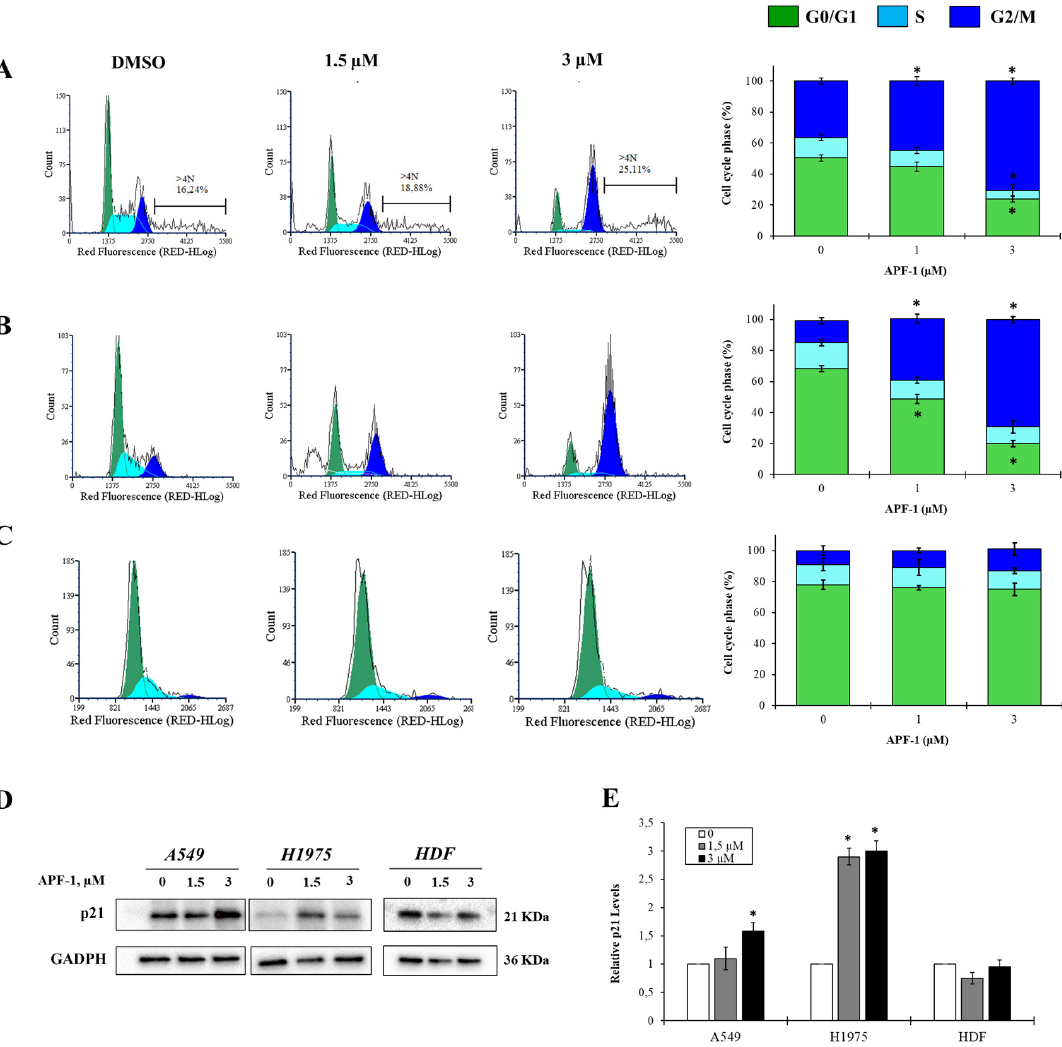
Figure 4. Effects of APF-1 on cell cycle distribution and p21 waf1/cip1 expression. Cells were treated for 24 h with 1.5 and 3 µM APF-1 concentrations. H1975 ( A ), A549 ( B ), and HDF ( C ) cell cycle distribution was determined by PI staining and flow cytometry. On the left, there are representative cytograms obtained using cytofluorimetric DNA Cell Cycle Analysis protocol reprocessed with FCS Express 7 software (Pasadena, CA, USA); on the right there are the histograms of the cell percentage in G0/G1, S, and G2/M phases. ( D ) Immunoblot analyses of A549 and H1975 cells treated with APF-1 . Cells were lysed 24 h after exposure to APF-1 , then extracts were analyzed by Western blot with anti-p21. GADPH was used as an internal loading control. Densitometric analyses showed differences in the p21 expression level ( E ). The samples were derived from the same experiment and the blots were processed in parallel (Figure S1). * p < 0.01 versus untreated control cells.